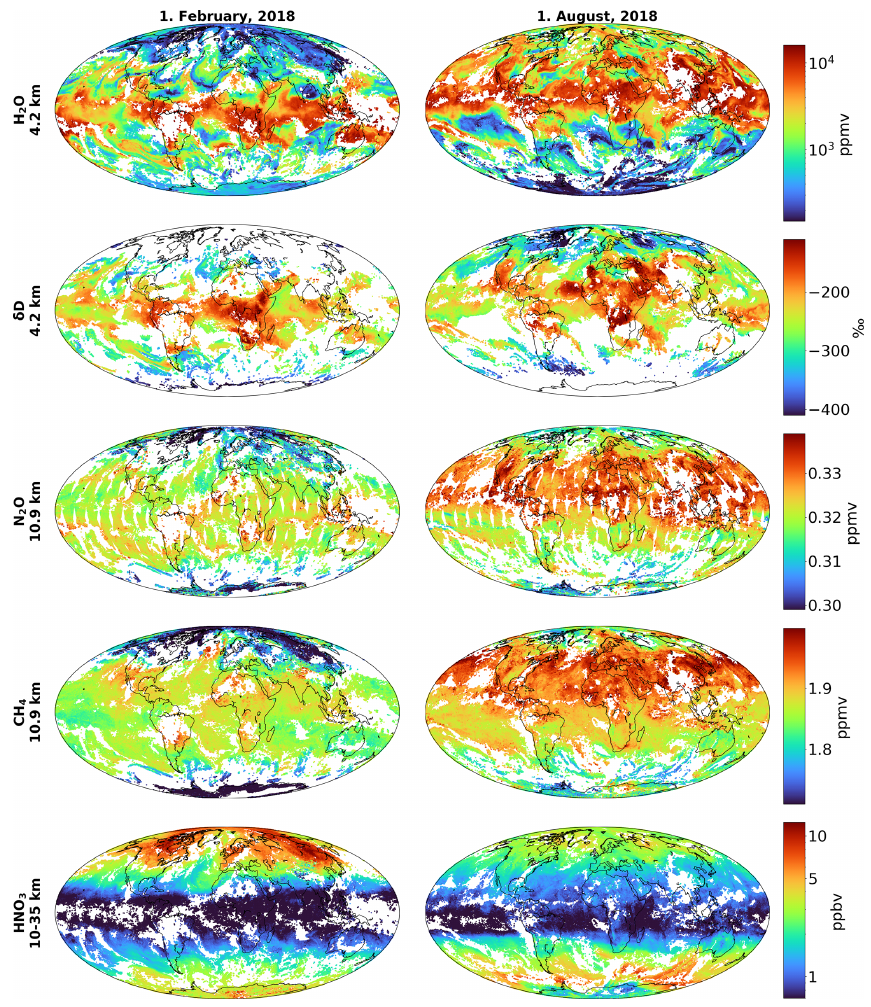
Figure 15. Daily maps for 1 February and 1 August 2018 of the trace gas products for the same altitudes as in Fig. 14. Altitude 4.2kma.s.l. for H 2 O and δ D, 10.9kma.s.l. for N 2 O and CH 4 , and 10–35kma.s.l. for HNO 3 . Data have been filtered according to the filter settings given in Table 4 (same as for Fig.